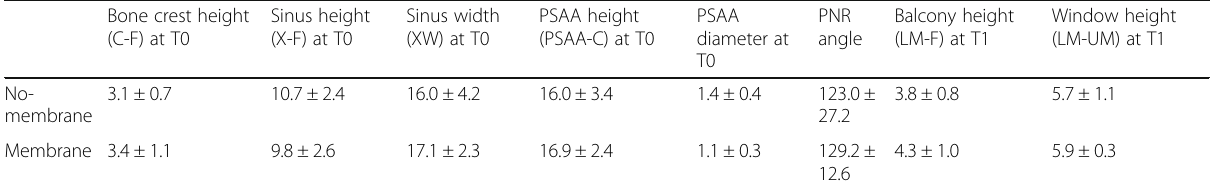
Sinus height (X-F) at T0